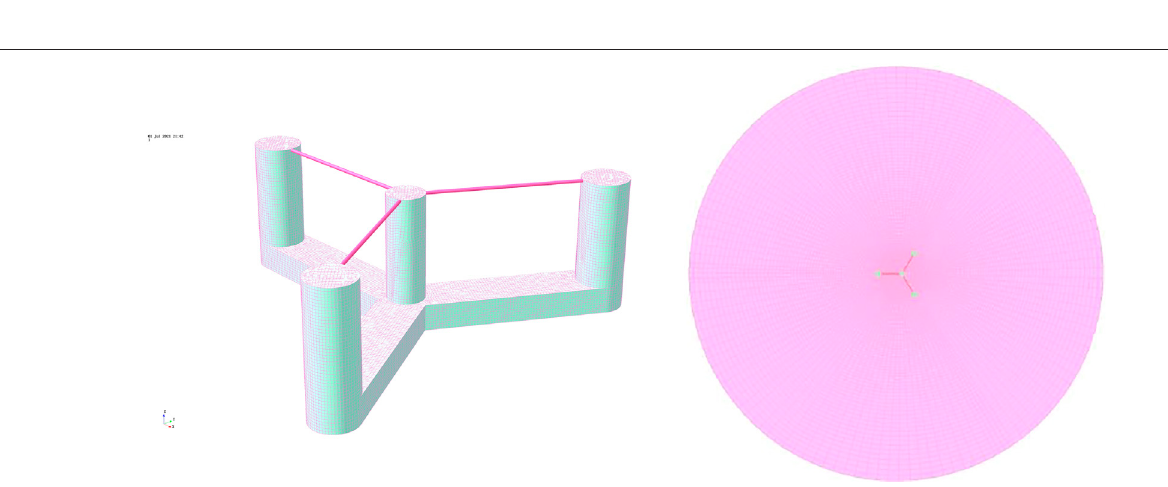
Frontiers in Energy Research |